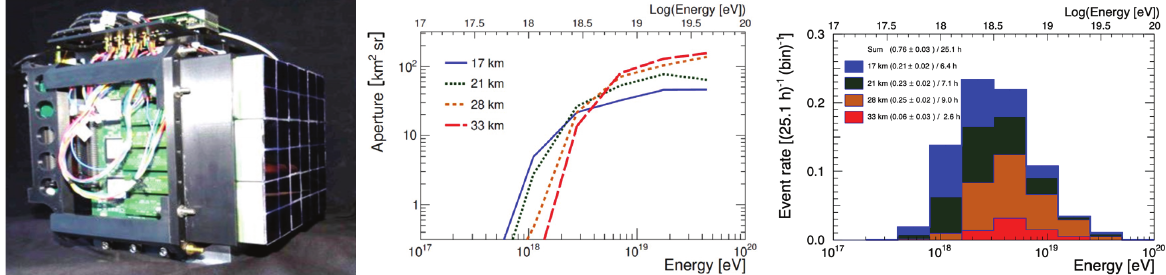
Figure 6. Left: JEM-EUSO’s second generation PDM, used in the EUSO-SPB mission. Center: EUSO-SPB realised aperture. Right: EUSO-SPB expected event rate. See [25] for details.